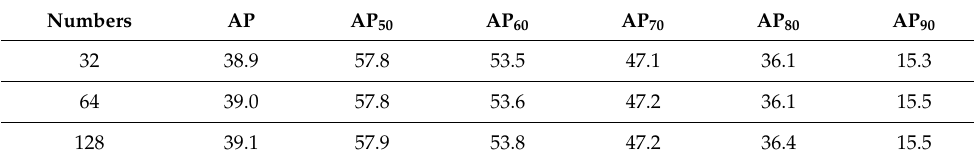
Table 2. The impact of the number of samples for IoU regression.